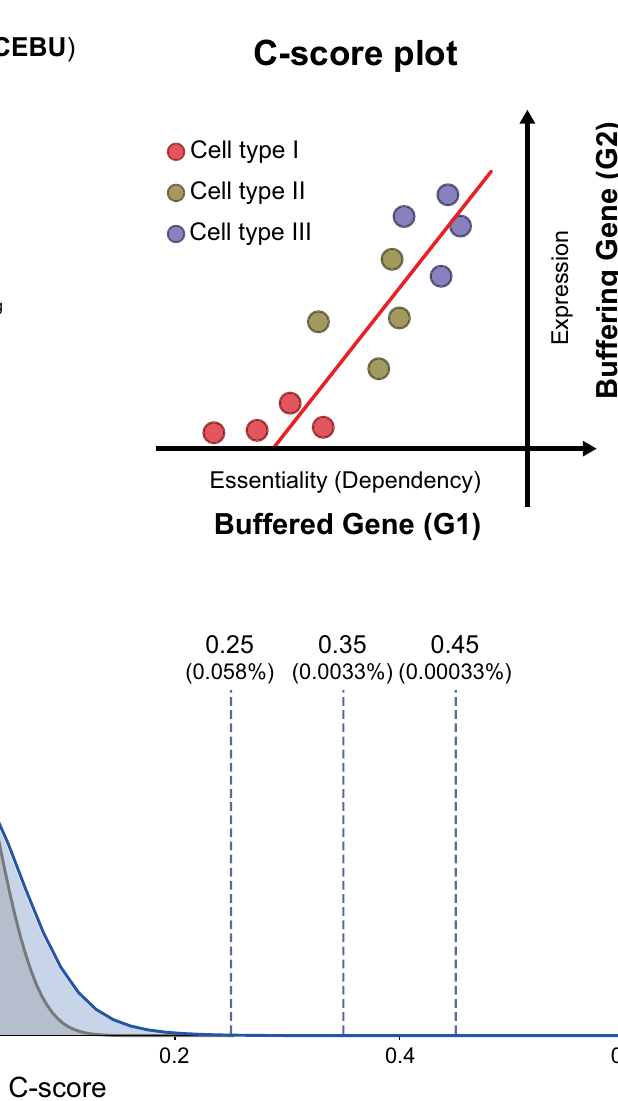
Figure 1. Genome-wide CEBU analysis using the C-score index. ( A ) Illustration of the cell-specific expression- buffering mechanism (CEBU). Cells with higher buffering gene (G2) expression (darker arrow) have stronger buffering potential, thereby lowering the essentiality of the buffered gene (G1). The illustration and cartoons are created using Adobe Illustrator. ( B ) C-score plot: the x-axis is the dependency score of the buffered gene (G1) and the y-axis is the expression level of the buffering gene (G2). G1 is considered as being potentially buffered by G2, as quantified by C-score, which is an adjusted correlation for a given gene based on the C-score plot. ( C ) Distribution of C-scores for all gene pairs (blue) and one of five randomly shuffled distributions (grey). The plot shows C-score between 0.4 and 0.6. The dashed lines indicate the C-score percentiles of 0.25, 0.35 and 0.45 for the all-gene-pair